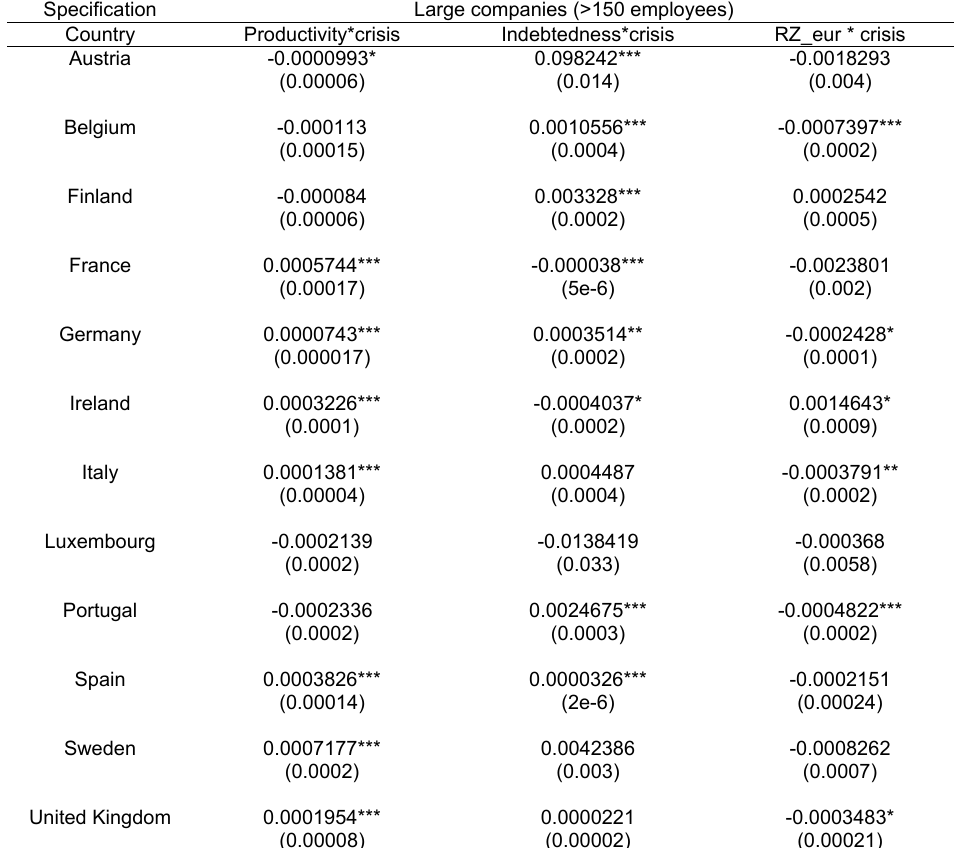
Table A.5. Cross-country effects (large companies)